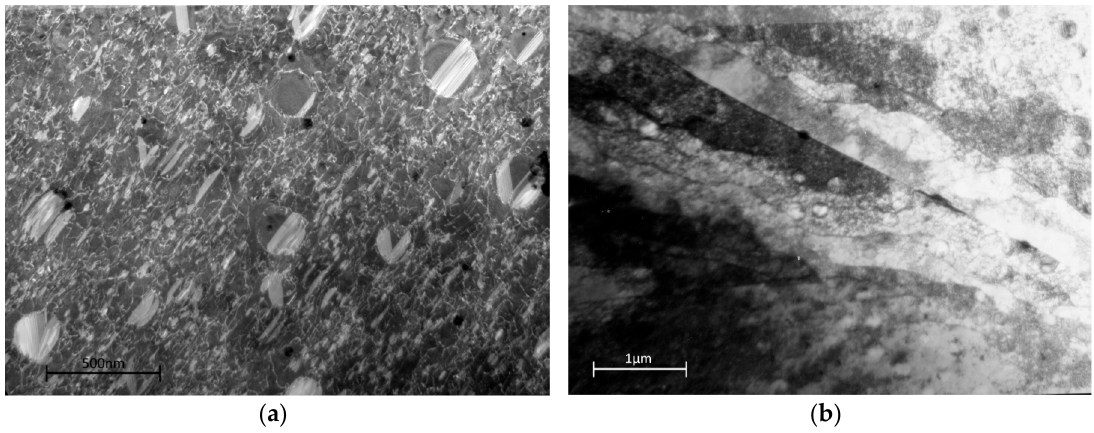
Figure 12. Dislocation structure in Waspaloy subjected to creep loading at 600 MPa (below the yield stress) in the ( a ) grains ( b ) grain boundary zones.